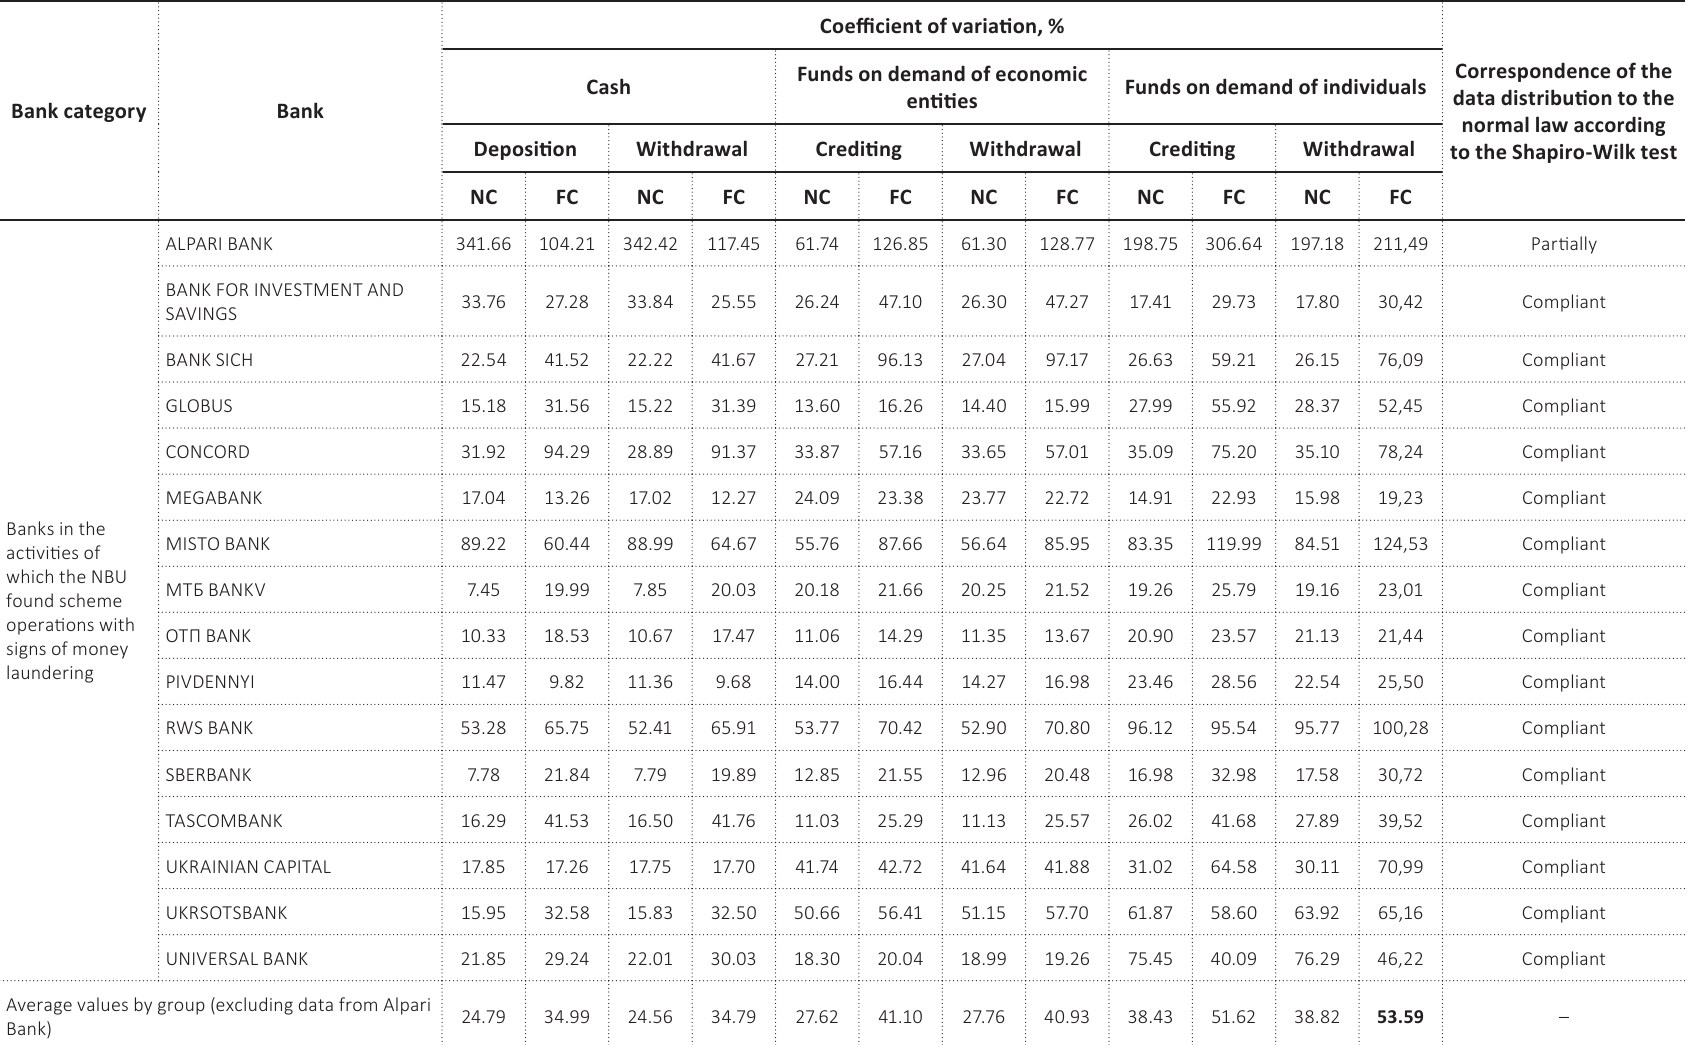
Table 6. Generalized results of calculating the coefficient of variation of cash flow by cash registers and accounts on demand of bank customers for the Bank category Bank